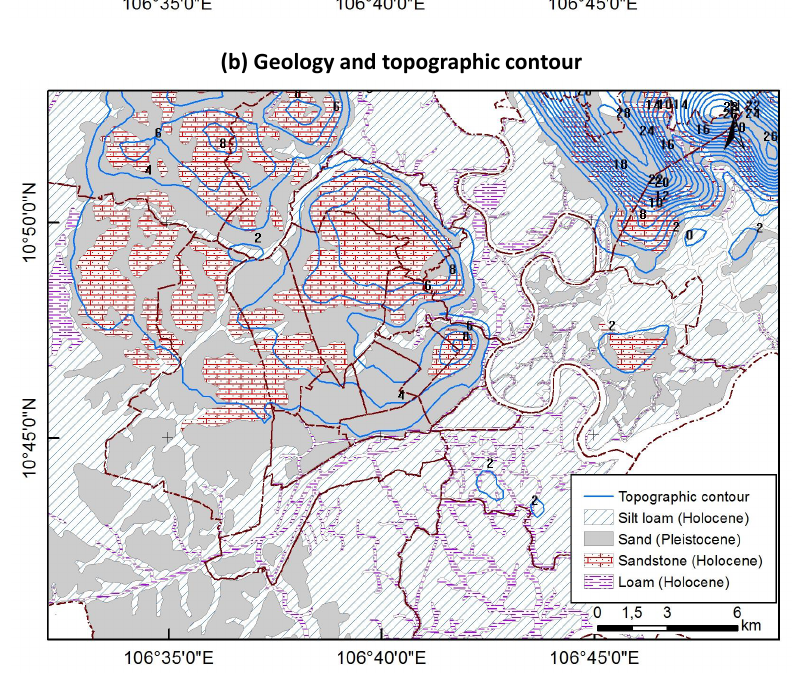
Figure 2. ( a ) Groundwater stations, water table velocity contour and leveling data; ( b ) geology and topographic